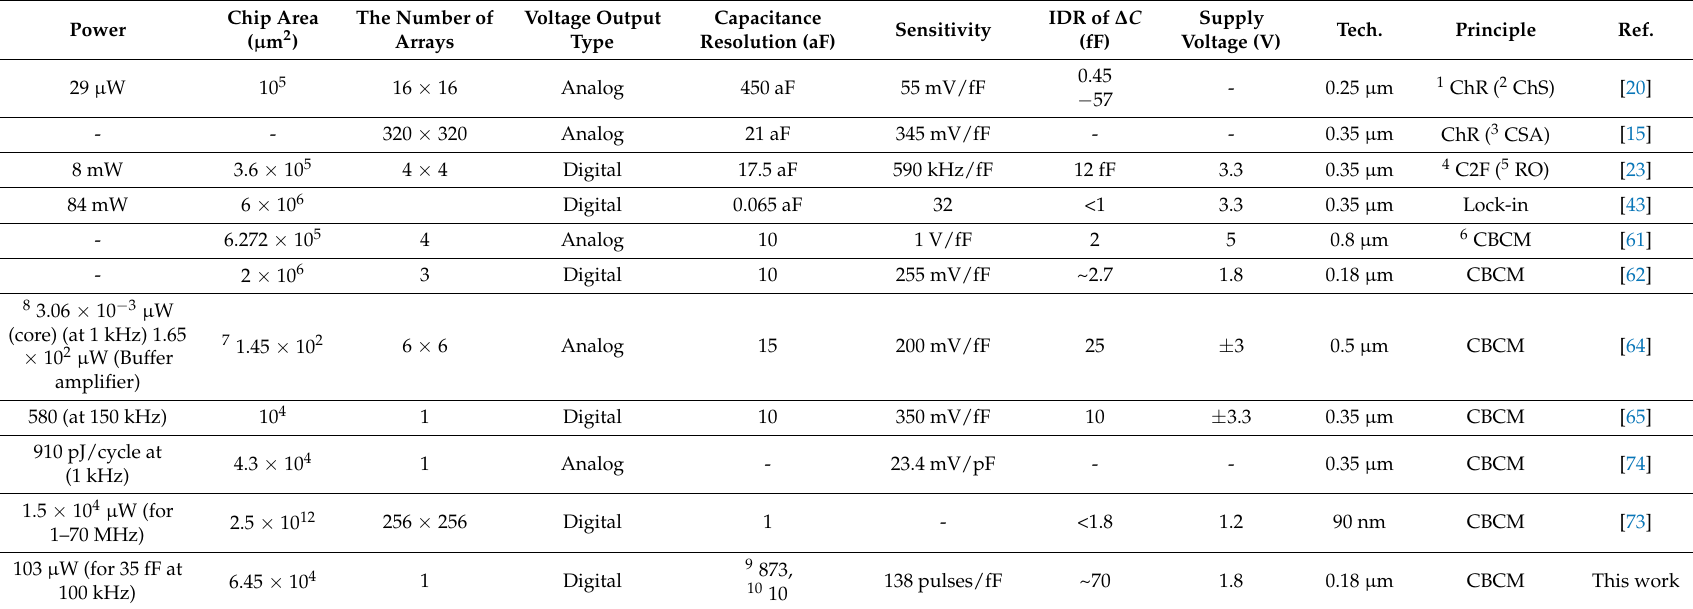
Table 4. Comparison of CMOS capacitive